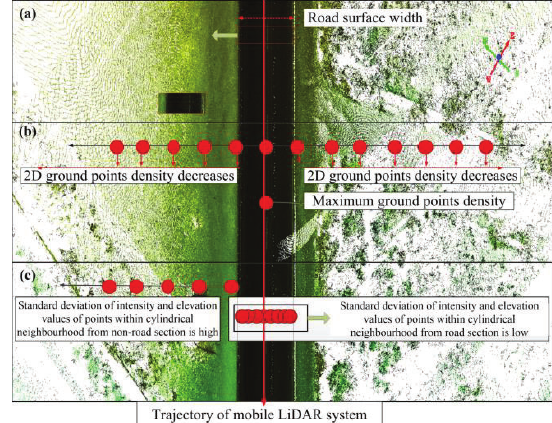
Figure 5. Showing (a) width of road surface; (b) ground point density decreases across the MLS path; (c) heights and intensity roughness parameters are uniform, respectively on the road